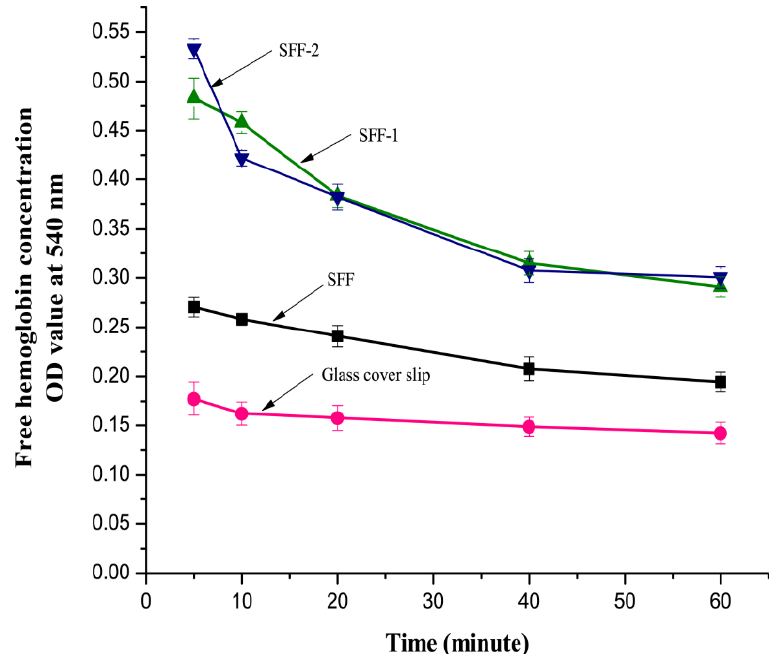
Figure 12. Rate of coagulation assay of untreated and surface modified silk fibroin fabrics at different time intervals. Data are shown here as mean (n = 3). Error bar = 1 × standard